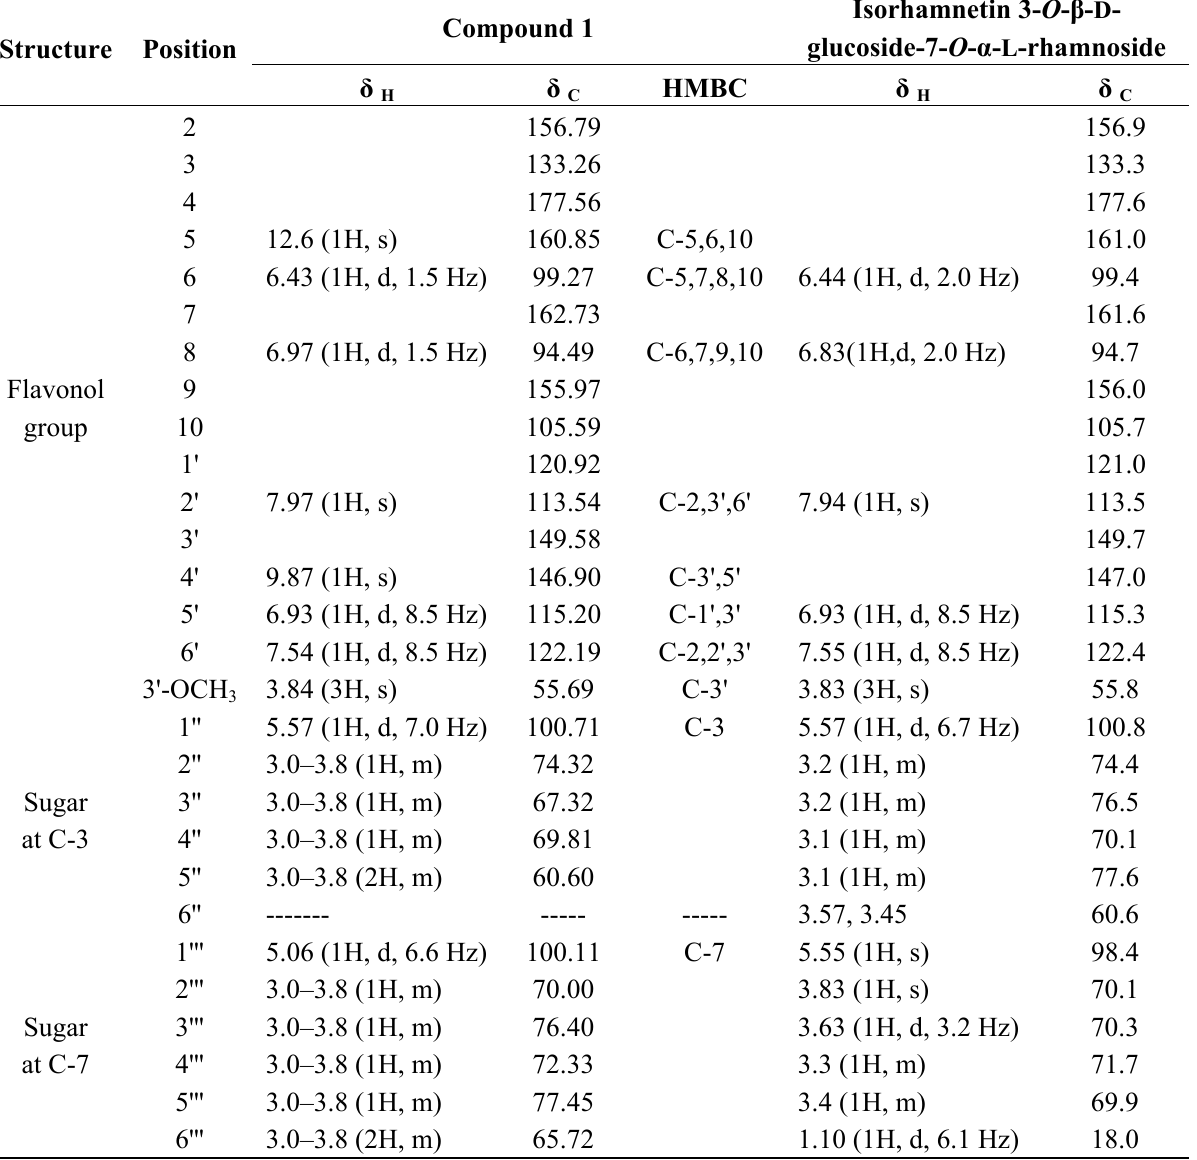
Table 1. 1 H-, 13 C-NMR and HMBC spectral data of compound 1 (in DMSO, δ in ppm, J in Hz).